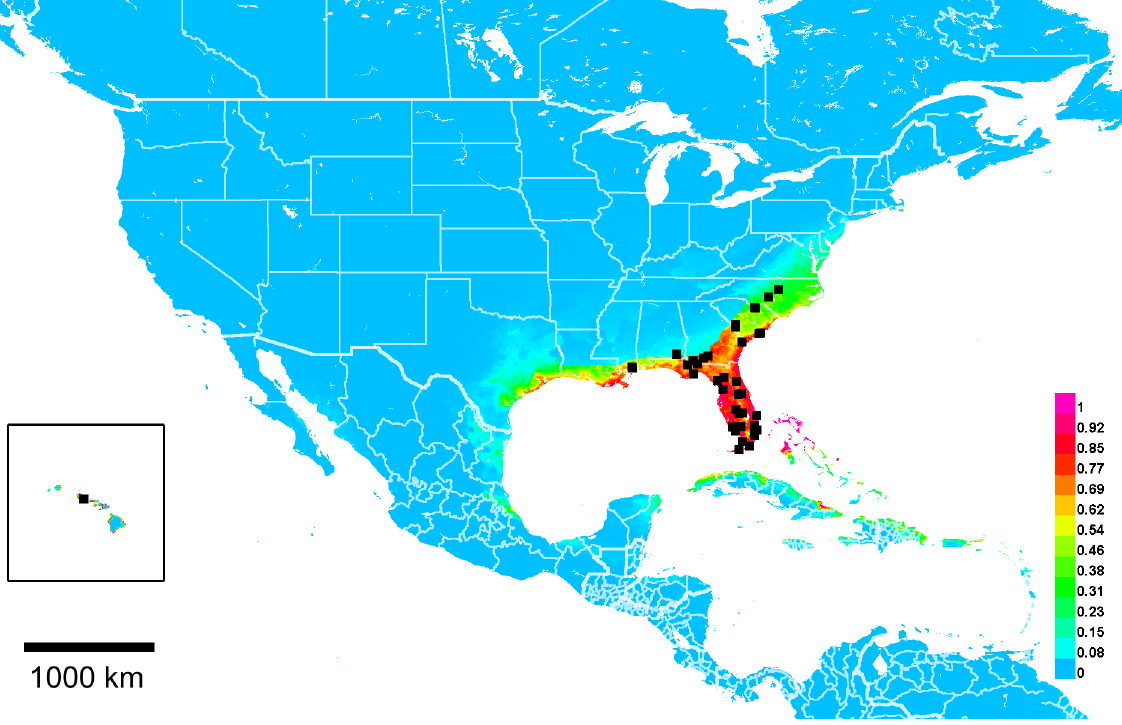
Fig. 56. Georeferenced collection records of Lasioglossum ( D .) puteulanum Gibbs, 2009 (black squares) and predicted distribution by maximum entropy ecological niche modelling in Maxent (colour shading). Warmer colours indicate higher cloglog probability of occurrence. Because many coastal records lacked soil data, the model was generated without soil type as an environmental